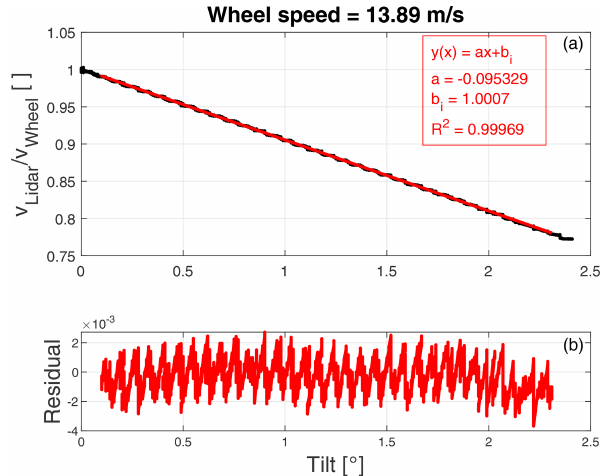
Figure 14. Example of calibration measurement made with a refer- ence speed of 13.89ms − 1 and a focus distance of 1.53m.